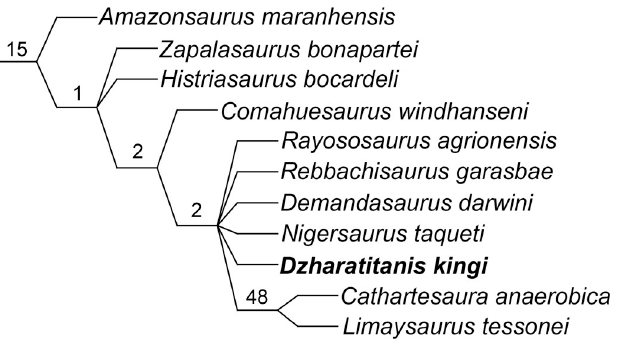
Fig 4. Part of the strict consensus of 1020 trees produced by TNT analysis showing the phylogenetic relationships within Rebbachisauridae and the position of Dzharatitanis kingi with GC values at the nodes.